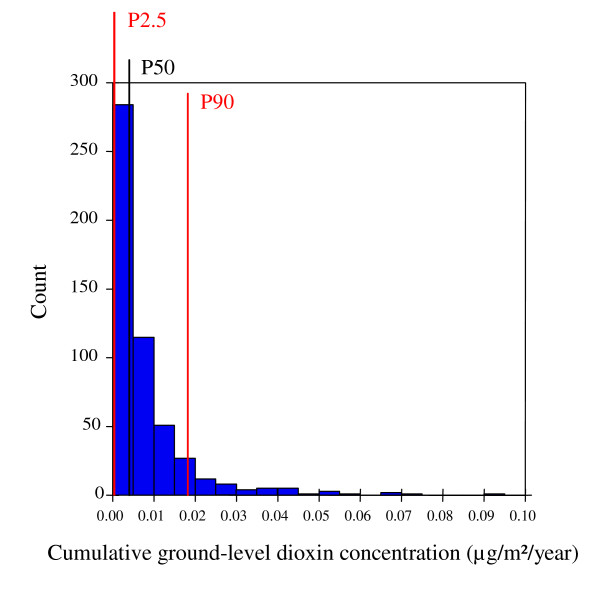
Dioxin exposure (modelled ground-level concentrations) distribution within modelled zones (520 block groups, France). P2.5 = 2.5th percentile (1.25 × 10-4 μg/m2/year); P50 = 50th percentile (4.25 × 10-3 μg/m2/year); P90 = 90th percentile (1.78 × 10-2 μg/m2/year).